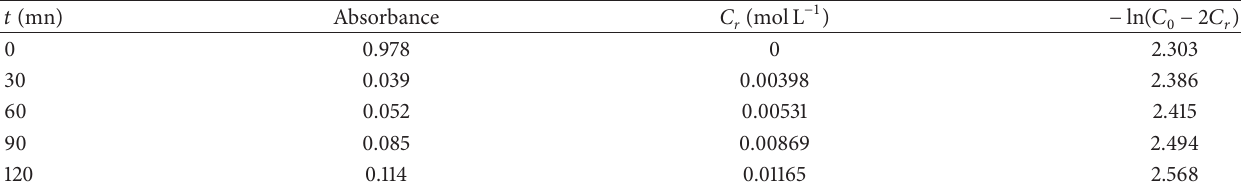
Table 1: Results for the facilitated extraction phenomenon of VO 2+ ions by SLM containing resorcinarene extractive agent. 𝑡 (mn)